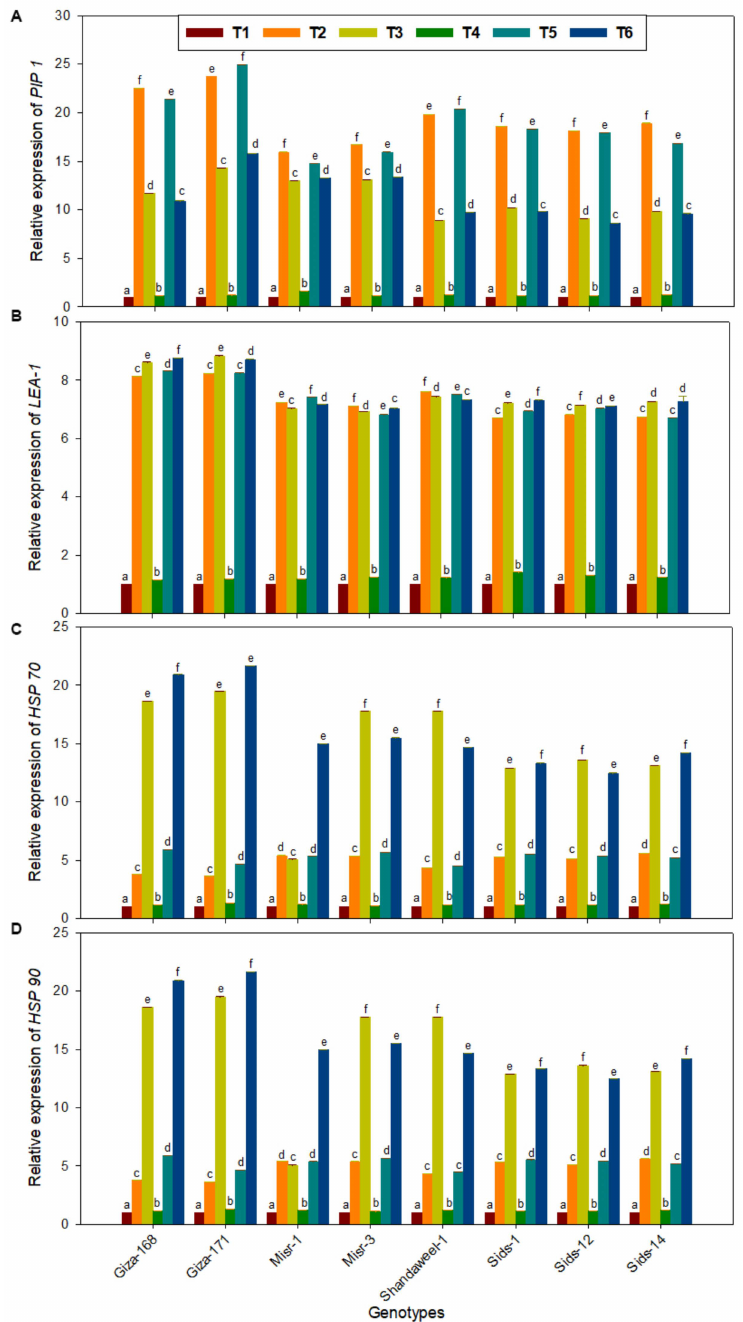
Figure 5. Expression of stress-responsive genes ( A ) PIP1 , ( B ) LEA-1 , ( C ) HSP 70 , and ( D ) HSP 90 of eight wheat genotypes grown under drought and heat stress and their response to SeNPs application. Different letters above the columns indicate statistically significant differences among treatments according to (Tukey’s HSD post hoc test) at p ≤ 0.05. Treatments: T1, control (regular irrigation, 100% field capacity (FC)) at (day/night) temperatures of 23/17 ± 3 ◦ C; T2, drought stress (60% FC); T3, heat stress (38 ◦ C); T4, 10 mg · L − 1 of SeNPs; T5, drought stress (60% FC) + 10 mg · L − 1 of SeNPs; and T6, heat stress (38 ◦ C) + 10 mg · L − 1 of